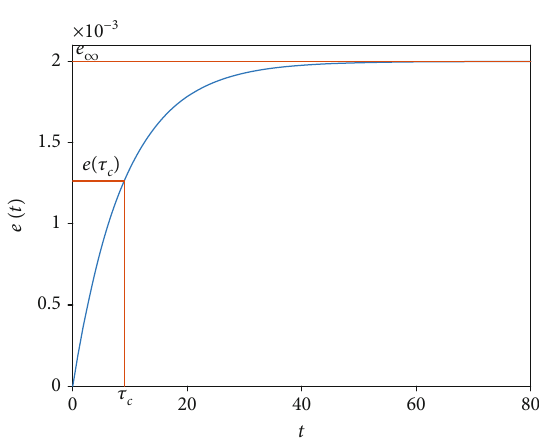
Figure 2: Viscoelastic creep under step load at the same e 10 − 3 condition and τ = 9 : 0 where t ( x -axis) is the time variable c and e ð t Þ ( y -axis) is the strain response at time t